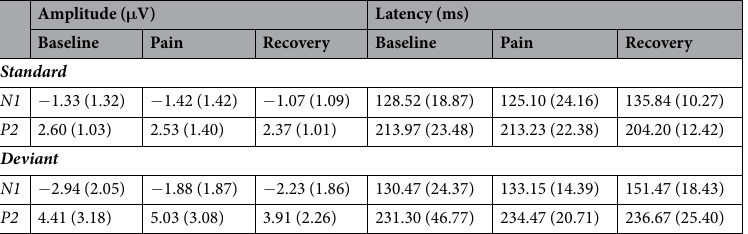
Table 3. Peak amplitude and latency of N1 and P2 to standard and deviant tones in cold pressor test at Cz electrode in experiment